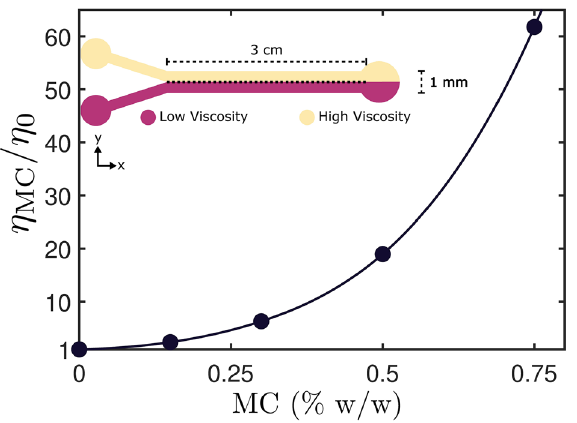
Figure 1. Dynamic viscosity measurements for the various solutions of DI Water and methylcellusose which were used as high viscosity media. The circles indicate the concentrations used during the experiments: 0.15%, 0.30%, 0.50% and 0.75%. In the inset, the geometry of the microfluidic device used to perform the experiment (inlets on the left, outlet on the right). Through laminar flow and balanced flow rates it is possible to generate two regions of equal width but different media, as highlighted by the different colours. The device schematic was drawn and added to the figure using the proprietary software Affinity Designer 1.8 (https ://affin ity.serif .com/ en-gb/desig